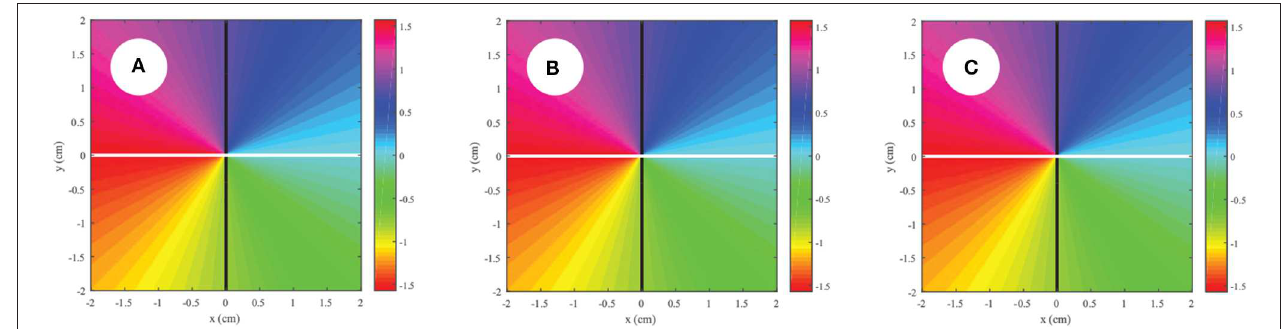
FIGURE 2 | Behavior of a coherent polarization singularity as the spatial coherence is decreased, with (A) δ